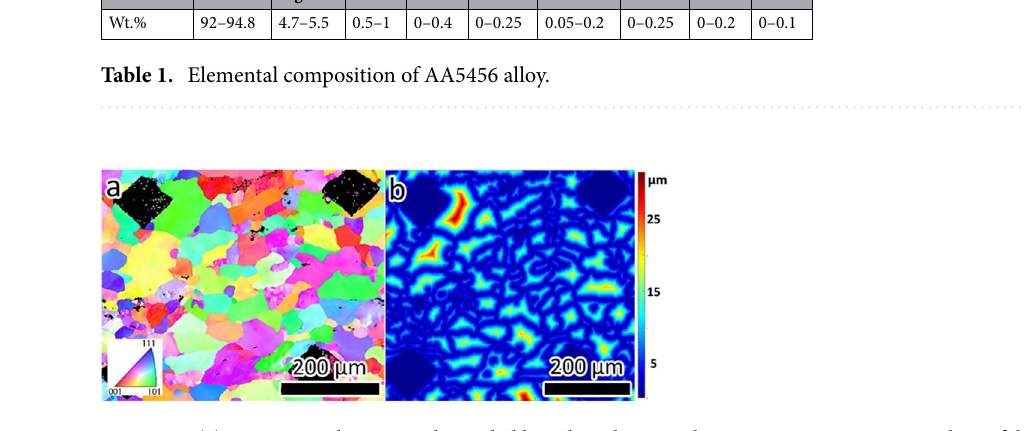
Figure 1. ( a ) IPF map with grains color coded based on the crystal orientation. Data points with confidence less than 0.1, as defined by the EDAX/TSL analysis software, are colored black. ( b ) Distance to grain boundary map used for calculation of GND density near the grain